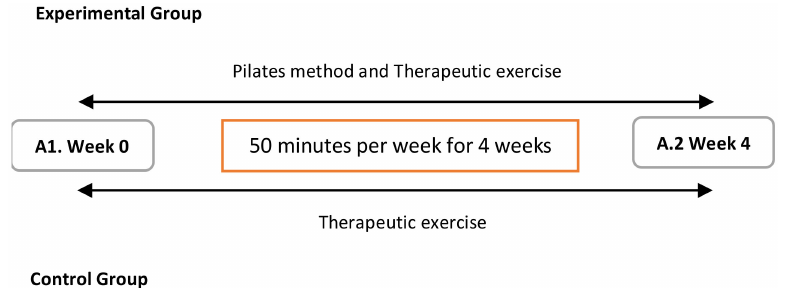
Figure 5. Measurement times. A1. Week 0: Assessment 1: Baseline situation pre-treatment; A2. Week 4: Assessment 2: Post-treatment results after 4 weeks of intervention for experimental and control